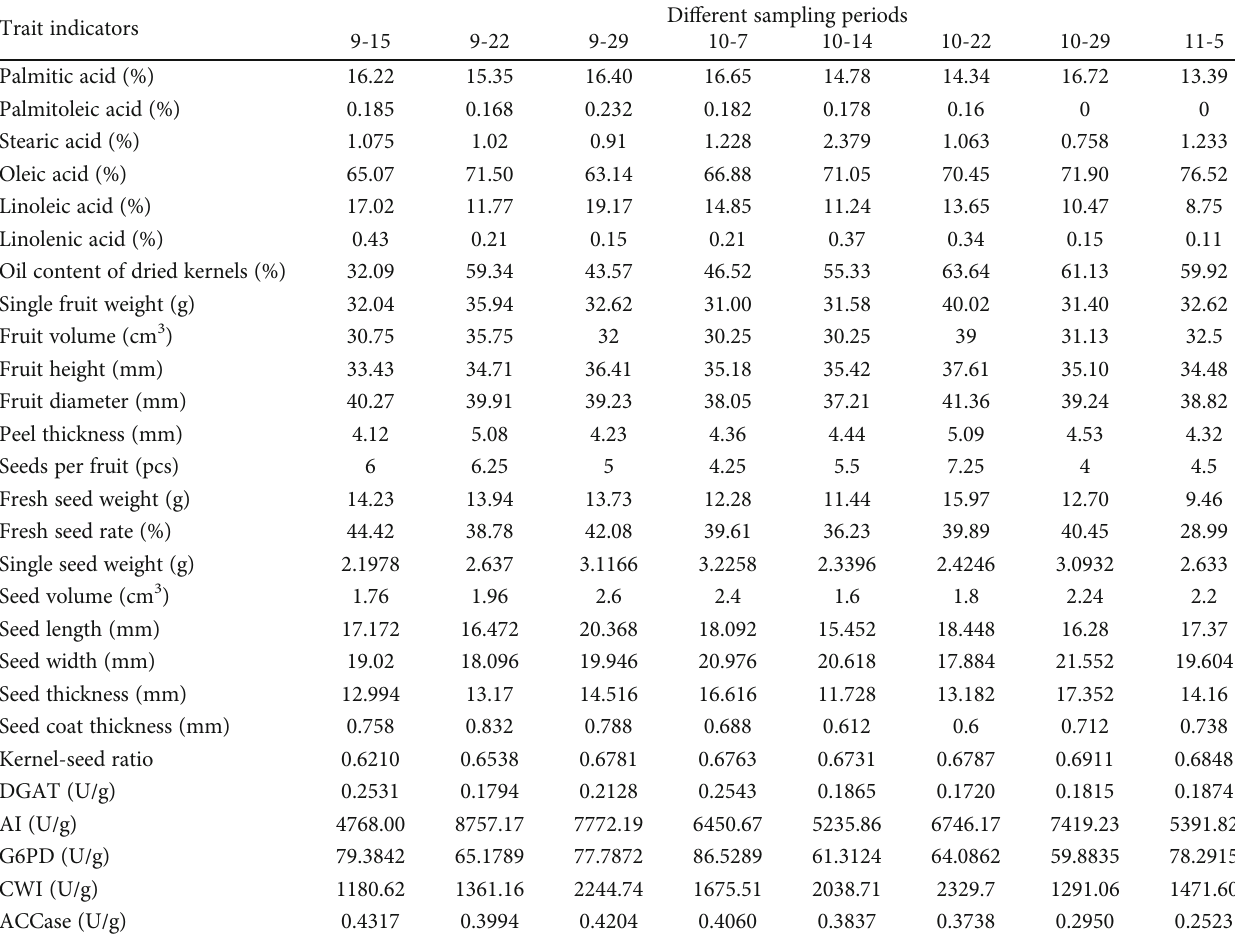
Table 2: Indicator value of characters in di ff erent periods of “ XL210 ”